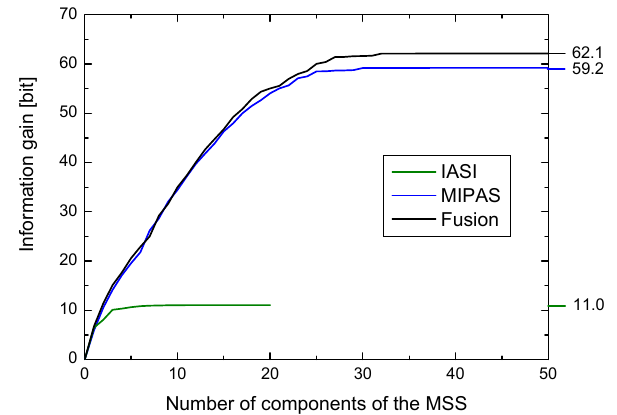
Fig. 4. AKs for the simulated case relative to 5km step altitudes, in the altitude range 0–80km, for the profiles retrieved using only the IASI measurement (a) , only the MIPAS measurement (b) and the IASI-MIPAS data fusion (c) .